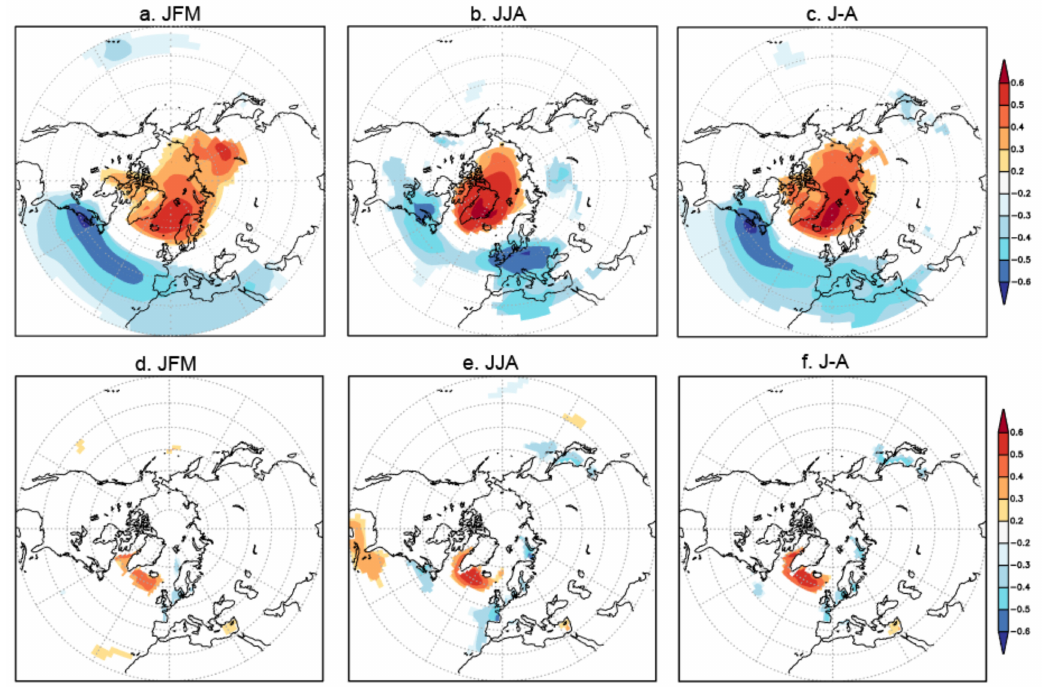
Figure 7. Spatial correlations between tree ring oxygen isotope with sea-level pressure ( a – c ) and sea surface temperature ( d – f ) during the period of 1950–1999. Correlations not significant at the 95% level have been masked